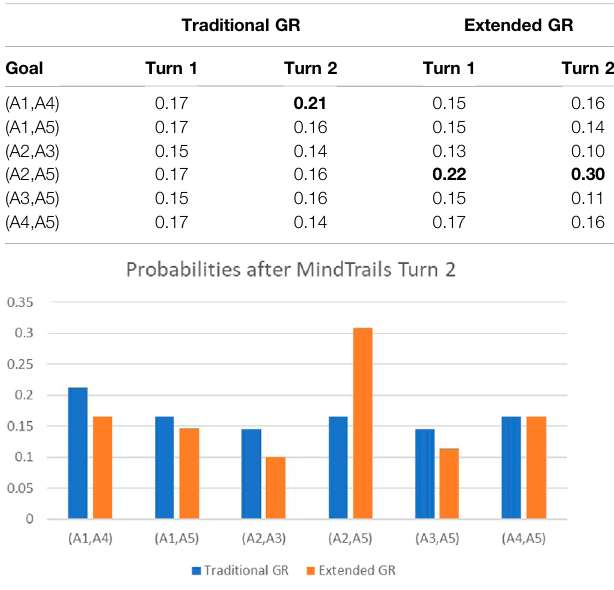
Table 1 shows probabilities calculated for each MindTrails goal (i.e., anchor pairs that may be linked)taking the game state as at Figure 4 (p.9) for Turn 1 and as at Figure 10 (p.17) for Turn 2. For traditional GR, probabilities were calculated using Eq. 2 , assuming